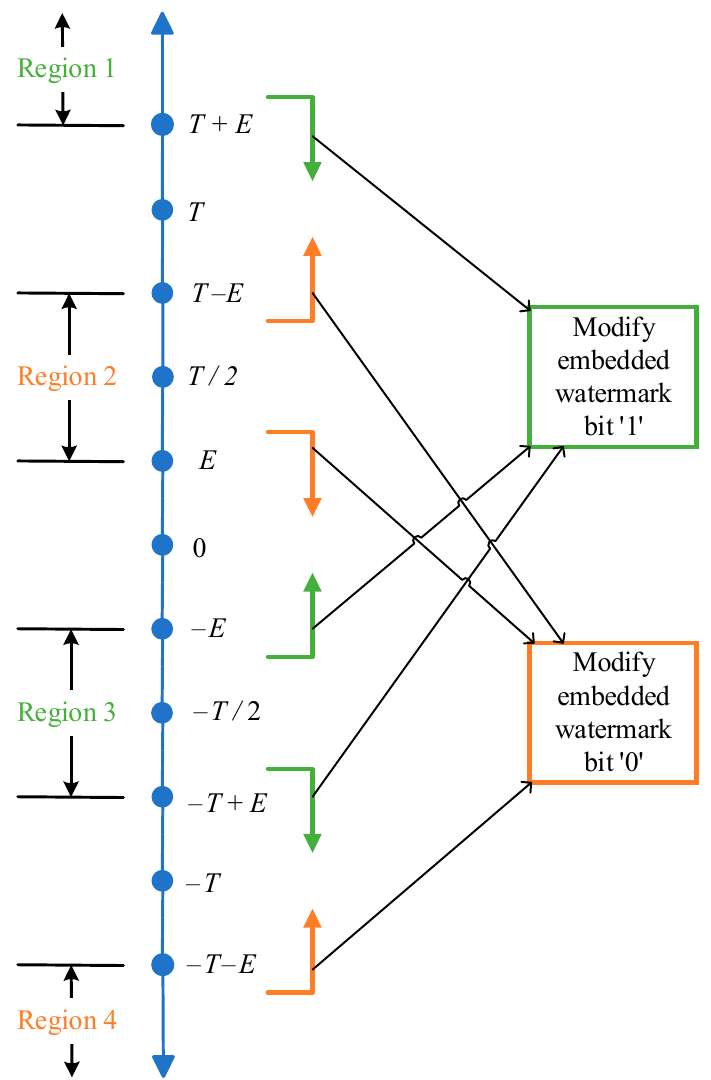
Figure 7. Modification of coefficient for embedding a watermark bit ’1 (cid:48) or ‘0 (cid:48) . Figure 7. Modi fi cation of coe ffi cient for embedding a watermark bit ’1 ′ or ‘0 ′ . Algorithm 4: Destroy Robust Watermark